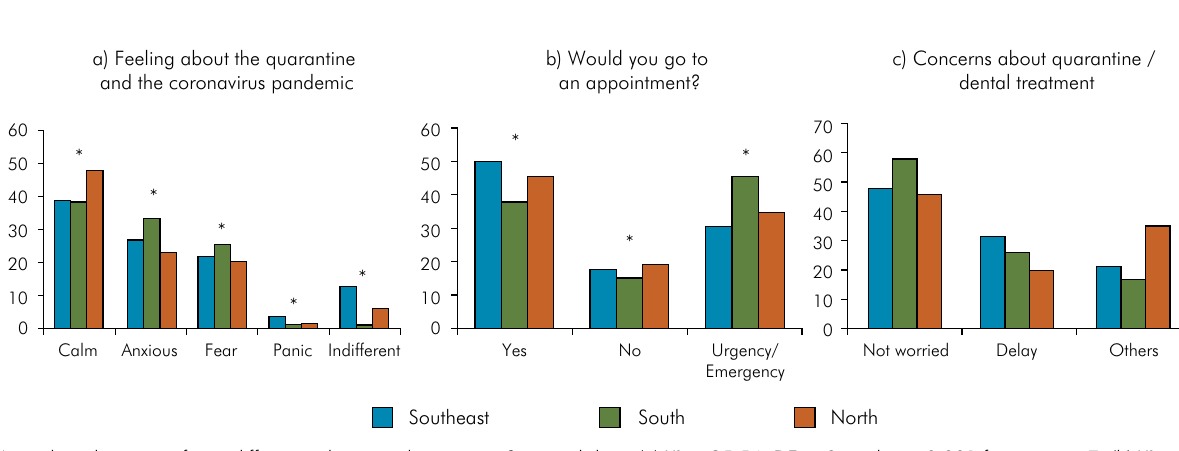
Figure 4. Comparison according to treatment specialty between patients being actively treated.